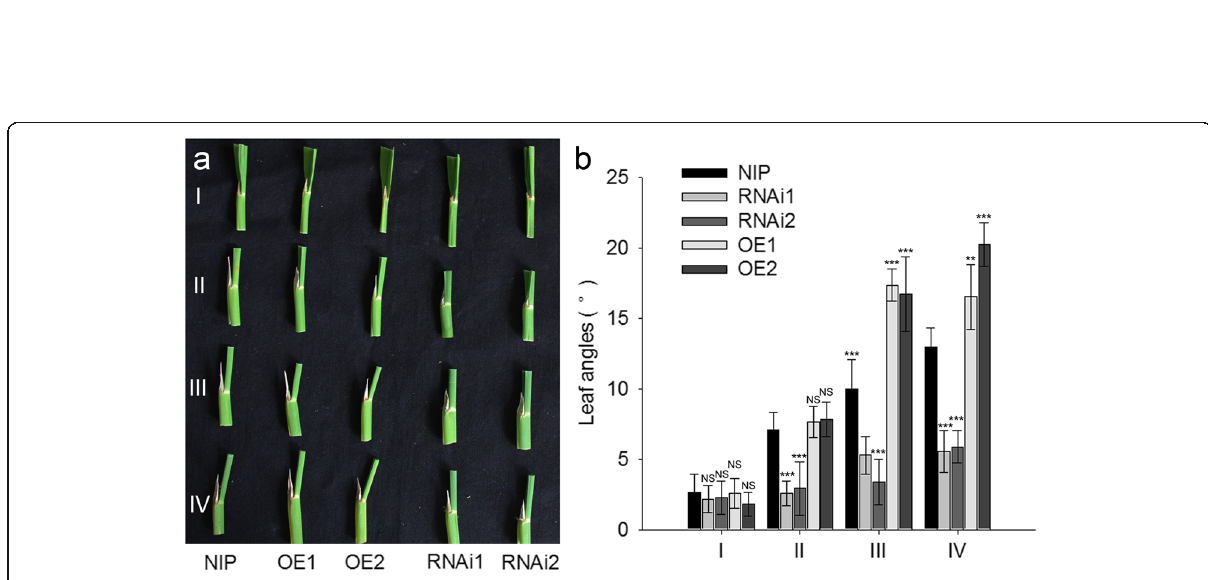
Fig. 5 The effect of GNS4 on leaf angle. a Comparison of the lamina joint angle of the flag (I), second (II), third (III), and fourth (IV) leaves (counted from the flag leaf downwards) between Nipponbare and transgenic plants. b Quantification of the leaf lamina joint angles. Data are shown as means ± s.e. ( n = 7). Significant at ***0.1%, and **1%. NS, not